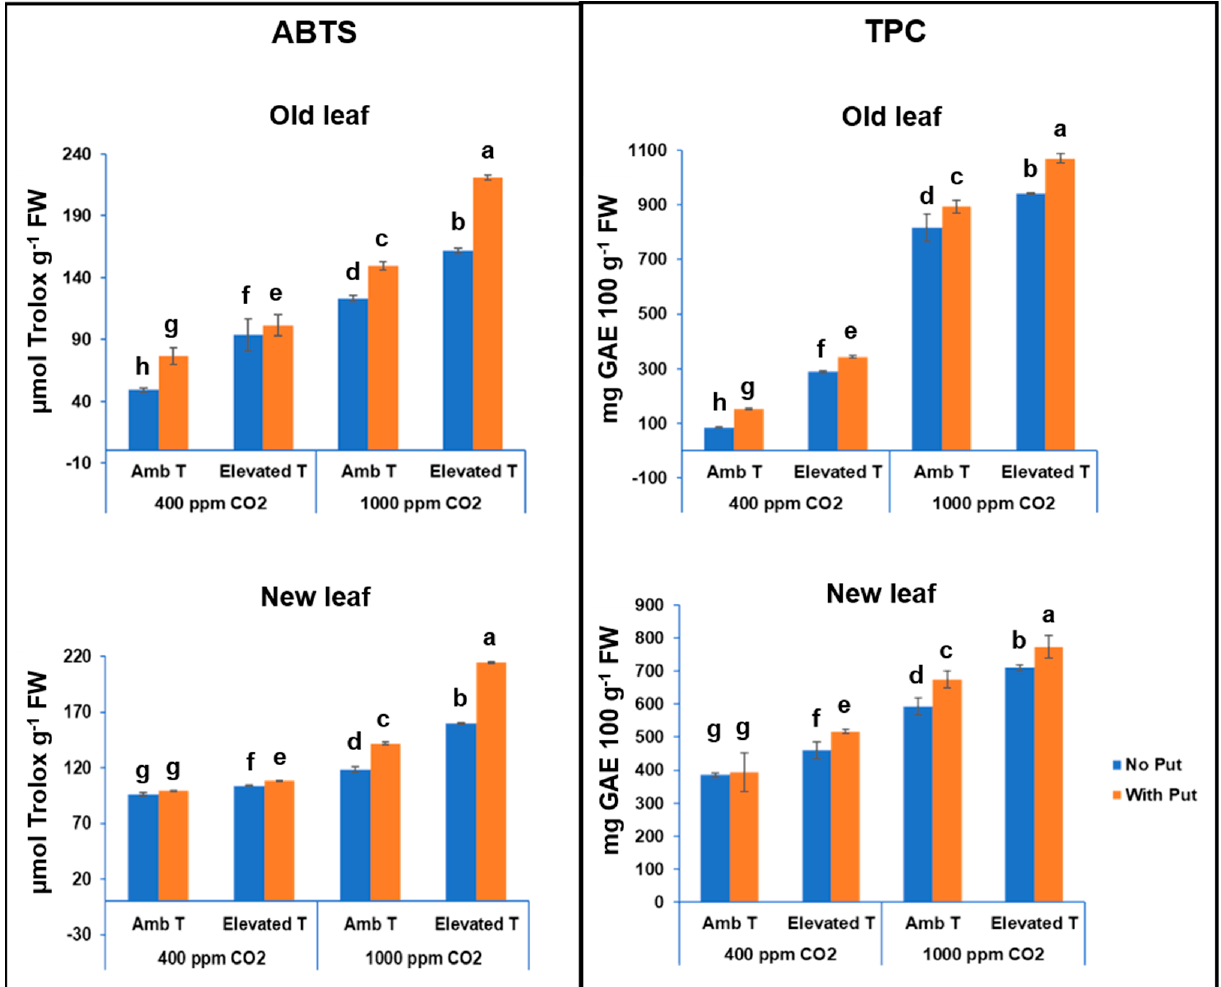
Figure 4. The antioxidant activity and total phenolic compounds in the outer and inner leaves of the cauliflower cv. Moonshine, along with the effect of short-term heat stress, CO 2 concentration, and the foliar application of 2.5 mM putrescine. The data are presented as the treatment means ( n = 5). Different letters represent significantly different mean values according to Tukey’s test at p ≤ 0.05.